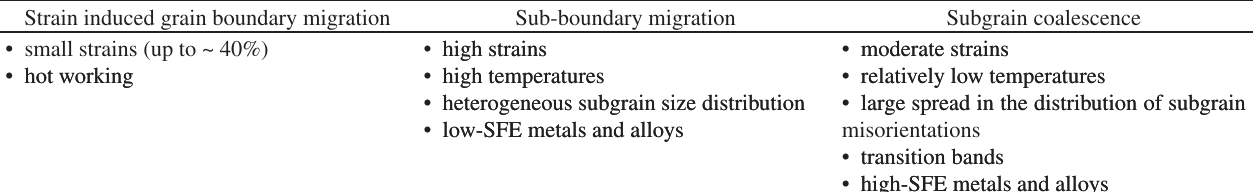
Table 1. Tentative summary for the mechanisms describing the start of recrystallization. Strain induced grain boundary